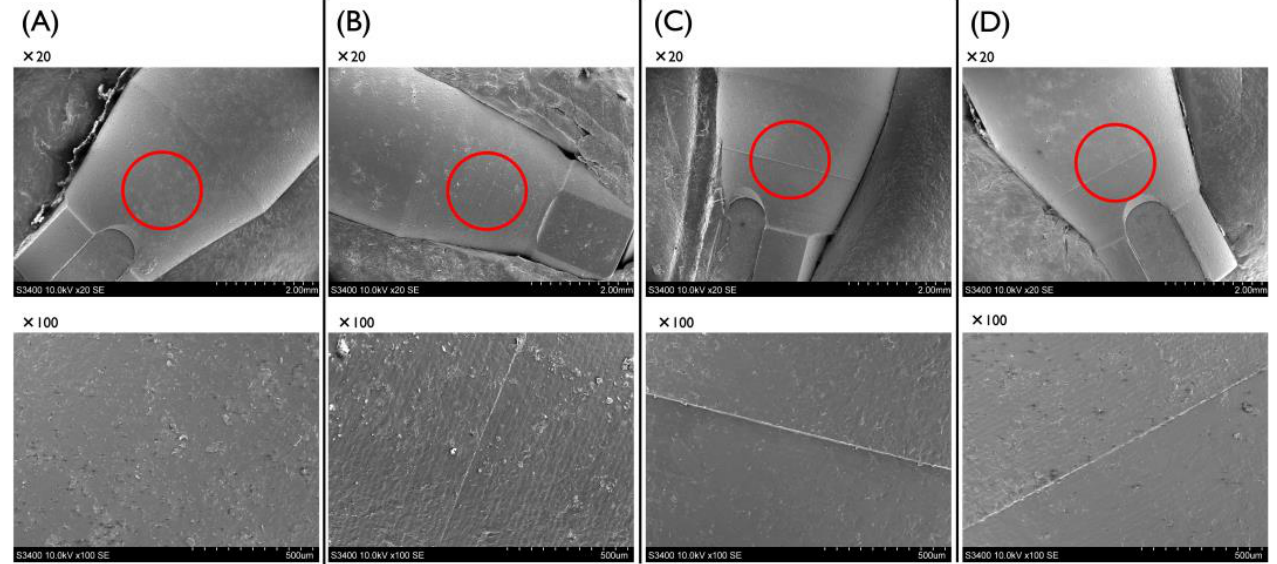
Figure 5. SEM observations of the surface of BL SBs. ( A ) The surface of an unused BL SB (20× and 100×). ( B ) The surface of a BL SB that had been connected once (20× and 100×). ( C ) The surface of a BL SB that had been connected/disconnected ten times (20× and 100×). ( D ) The surface of a BL SB that had received both autoclaving treatment and connection/disconnection ten times (20× and 100×).